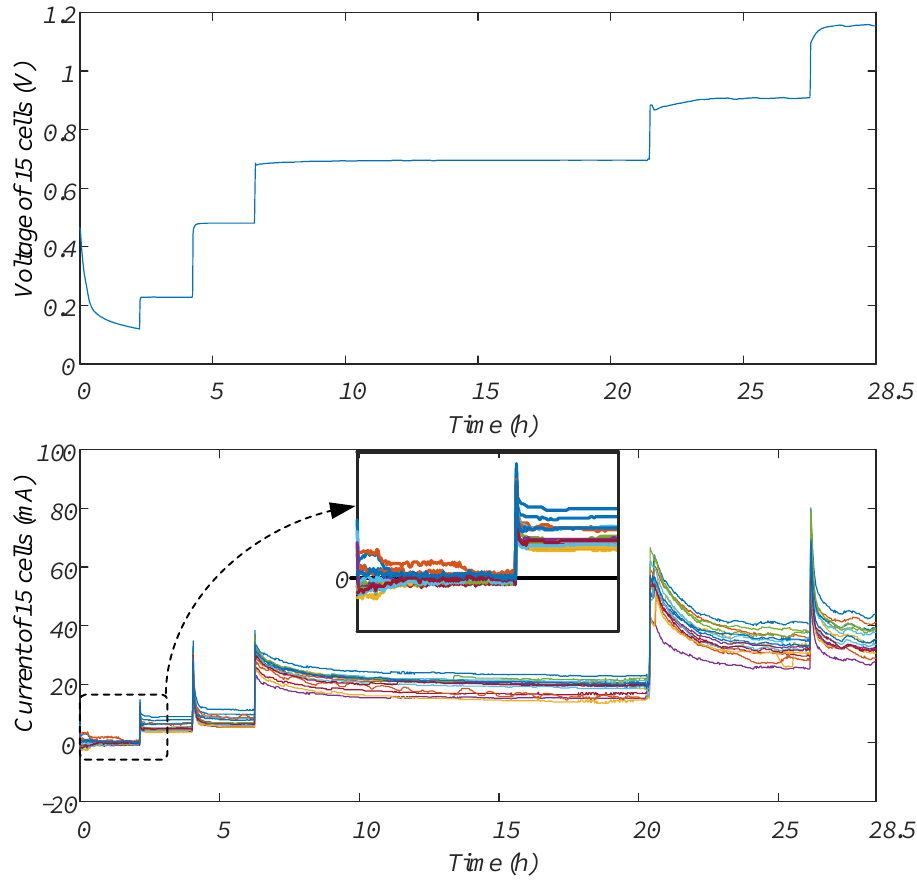
Figure 2. Current vs. voltage for 15 parallel EMG-BES cells.